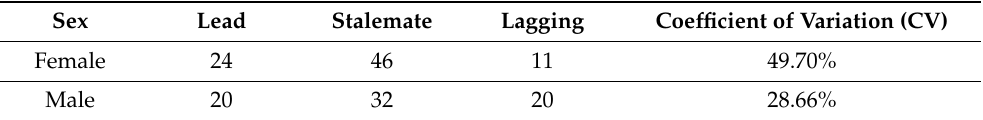
Table 5. The number of errors in different